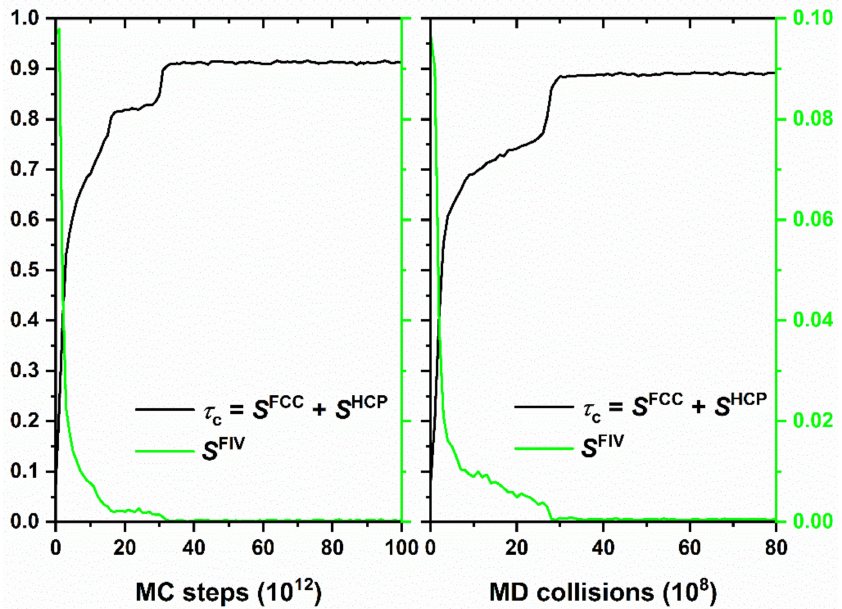
Figure 14. Evolution of crystallinity, τ c , and of the fraction of sites with fivefold (FIV) local symmetry, S FIV , as a function of MC steps ( left panel ) and MD collisions ( right panel ). Both the MC simulation, performed through the Simu-D suite, and the independent, event-driven MD simulation, are con- ducted on the same random initial configuration of 54,000 monomeric hard spheres of uniform size at a packing density of ϕ = 0.56. Total crystallinity is calculated here as the sum of fractions of sites with FCC and HCP character, as quantified by the CCE norm